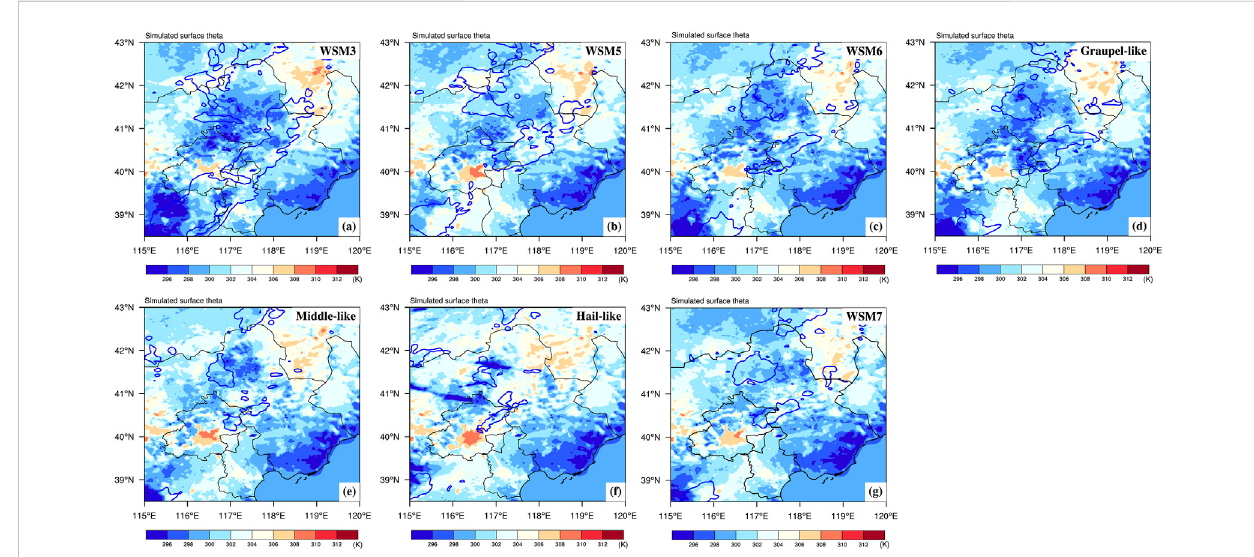
FIGURE 8 Simulatedsurfacepotentialtemperature(shaded;K)atconvectivedevelopmentstageforallsevenexperiments: (A) WSM3, (B) WSM5, (C) WSM6, (D) WSM6-Graupel-Like, (E) WSM6-Middle-Like, (F) WSM6-Hail-Like and (G) WSM7 experiments. The blue contours show the simulated 15 dBZ composite radar re fl ectivity.